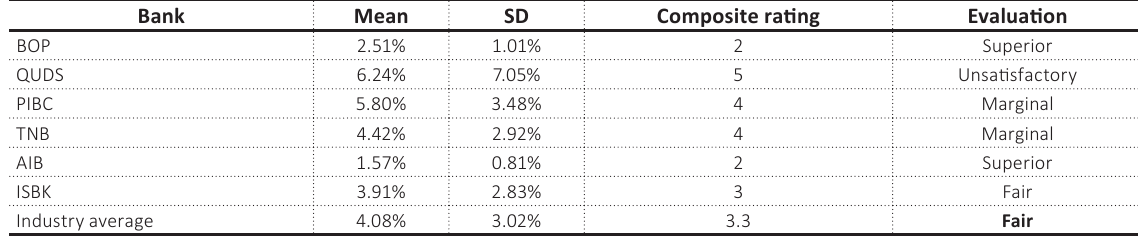
Table 6. Average non-performing loans